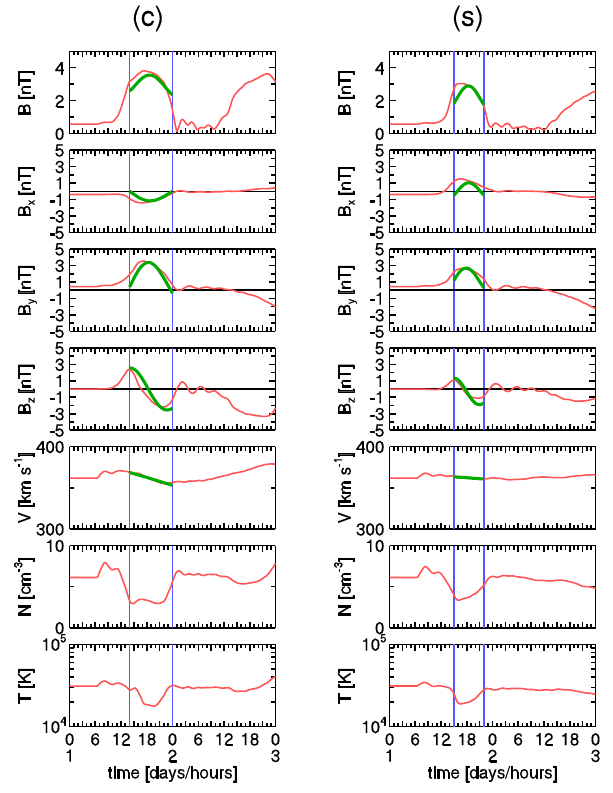
Fig. 2. Simulated time profiles (red) in the point A (c) and a point slightly above it (s) for the event I. The plot displays from top to bottom the magnetic field magnitude B , magnetic field components B x , B y , and B z (in GSE), velocity magnitude V , number density N , and temperature T . Vertical blue lines denote estimated flux-rope boundaries. Model fits are plotted by the thick green lines.